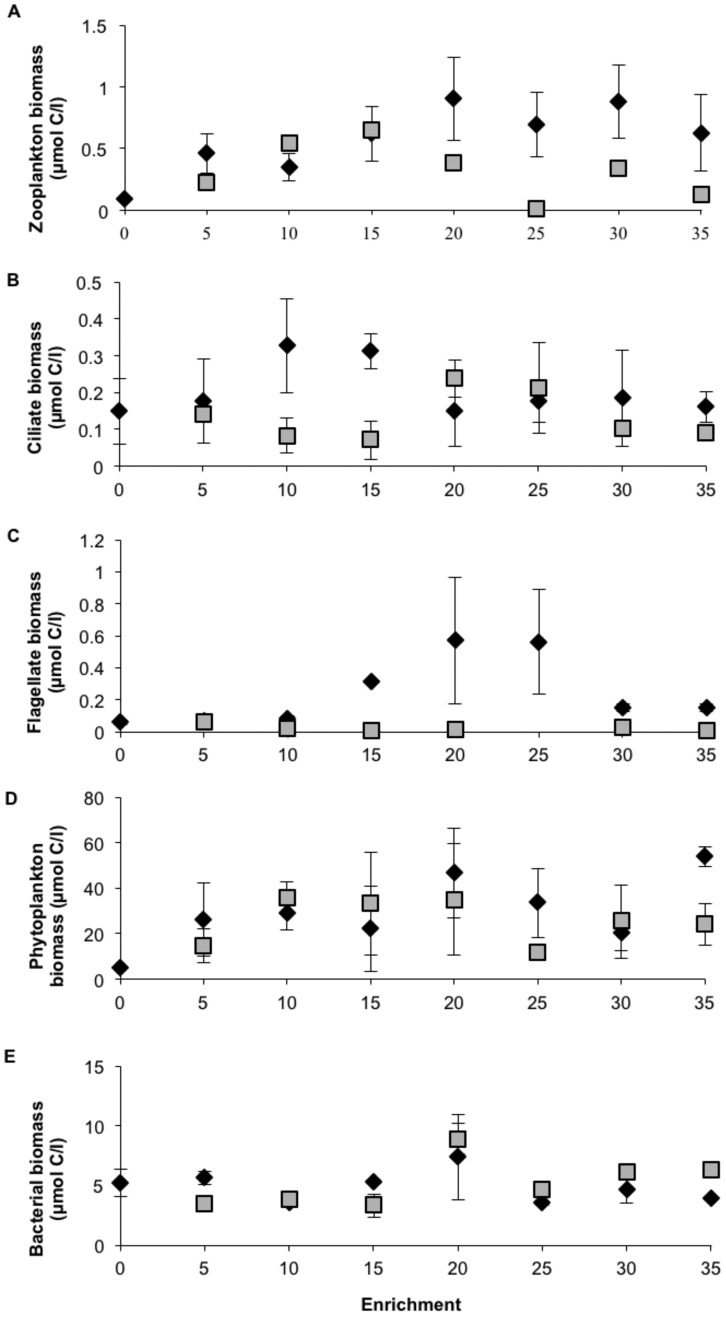
Biomasses of mesozooplankton (a), ciliates (b), flagellates (c), algae (d) and heterotrophic bacteria (e) for NP (⧫) and CNP (▪) treatments sampled during the two last weeks of the mesocosm experiment.Error bars are standard error (n = 2).